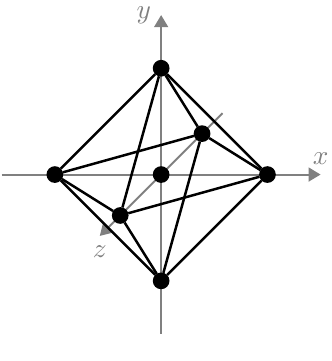
Figure 19 . Toric diagram for Q 1 , 1 , 1 / Z 2